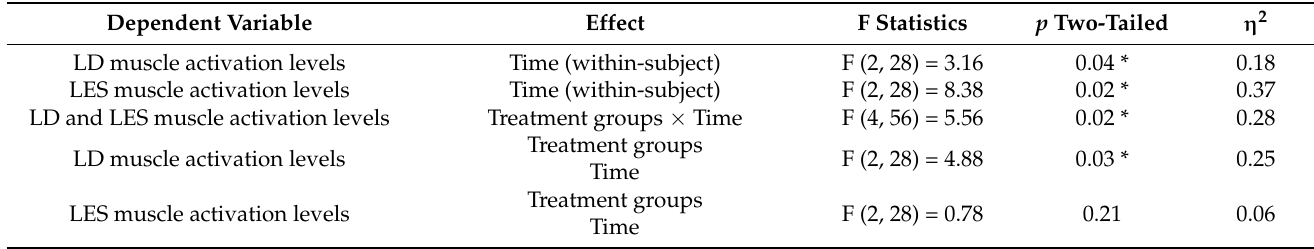
Table 5. Mixed-design repeated measures ANOVA test results with the lateral bending posture (180 ◦ upward